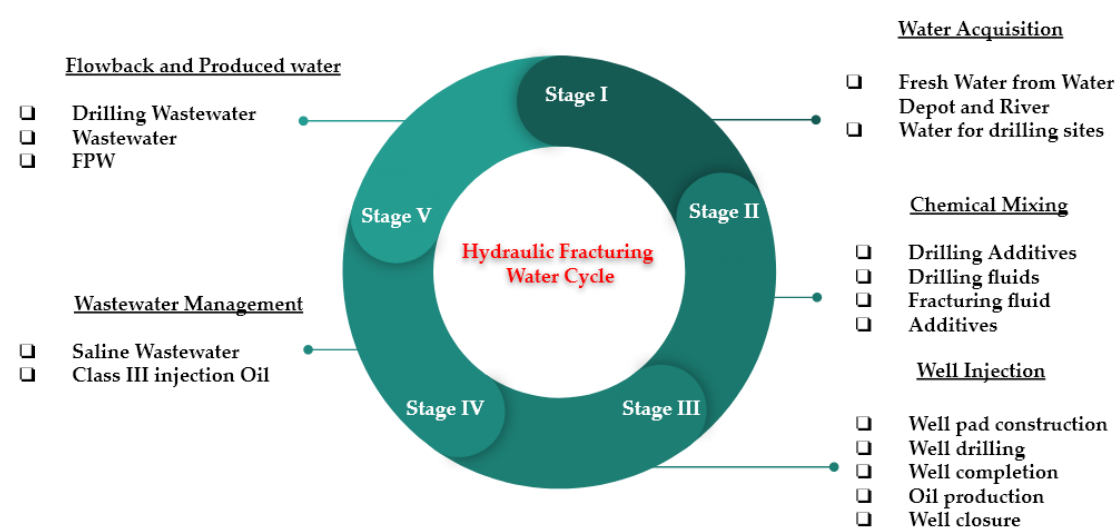
Figure 1. The five stages of the hydraulic fracturing water cycle and the consumptive and non- consumptive water use for oil production